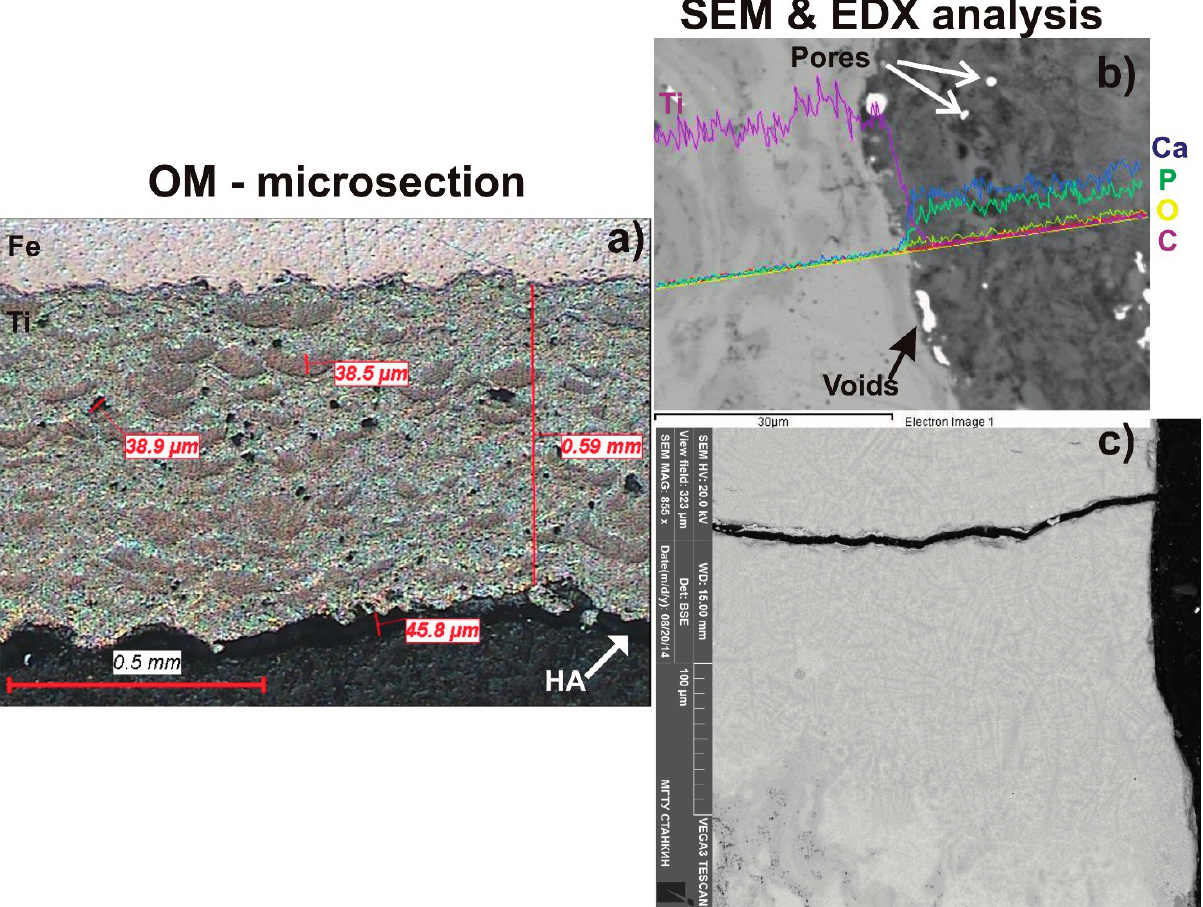
Figure 2. OM image ( a ) and SEM image ( b ) with element distribution after CCDS in HA + Ti system (Ti, Ca, P, O and C element map is shown on picture). SEM image ( c ) is a laser treatment of the CCDS surface, see